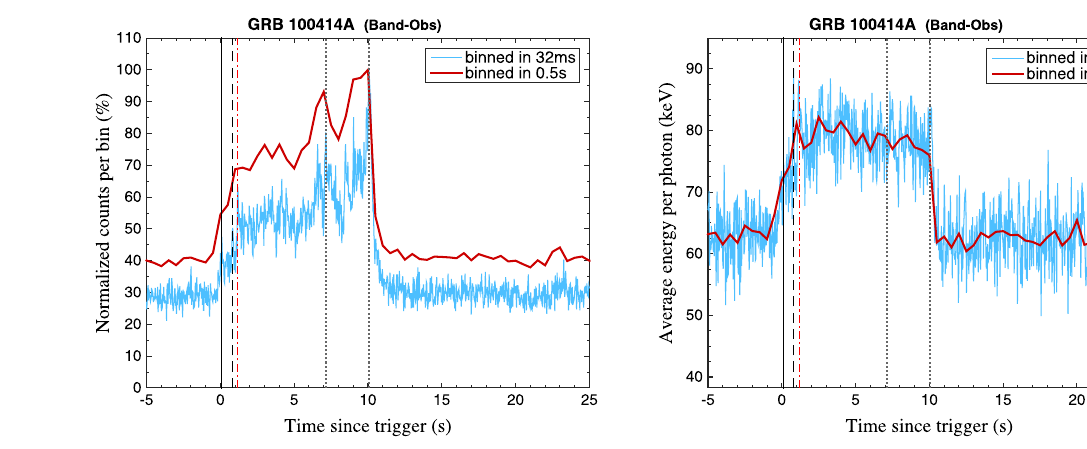
Fig. 10 The light curve and average energy curve of GRB 100414A in Band-Obs. The vertical solid lines refer to t obs /( 1 + z ) of Criterion 0 (the first main peak of the light curve) and the vertical dashed lines refer to t obs /( 1 + z ) of Criterion 2 (the significant peak of the average